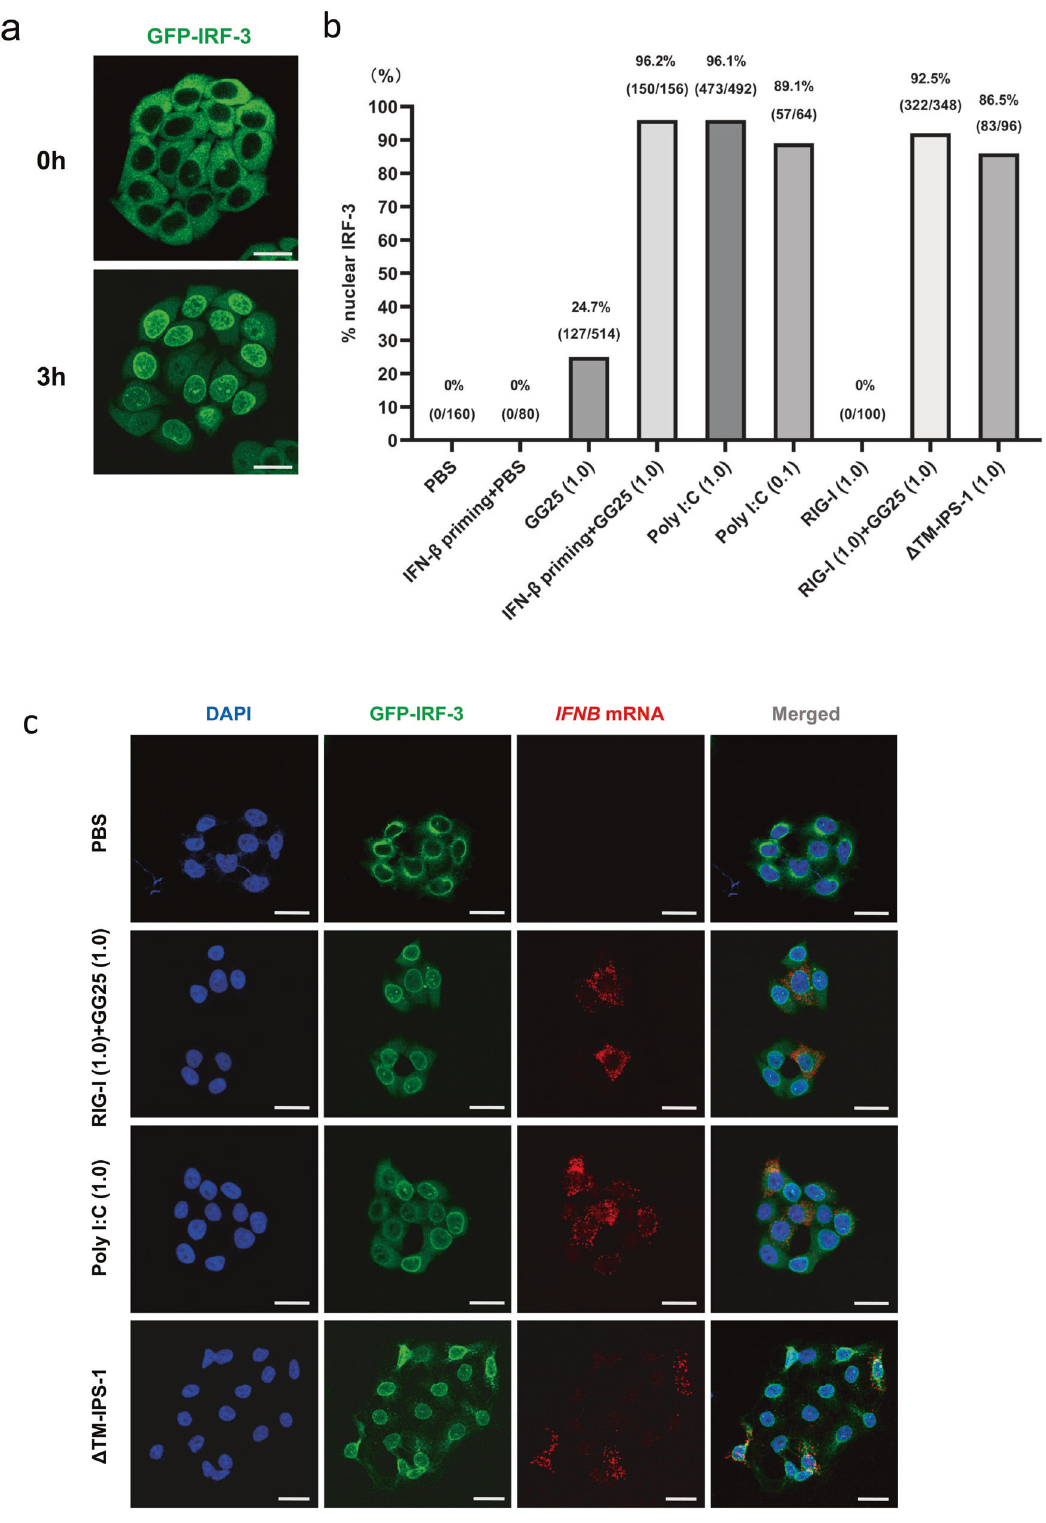
transfection of poly I:C induced both nuclear translocation of IRF-3 and SG. These results further supported PKR being essential in cell death induced by the poly I:C injection or transfection and are consistent with the poly I:C treatment inducing neither cell death nor SG. GG25 induced the nuclear translocation of IRF-3, but